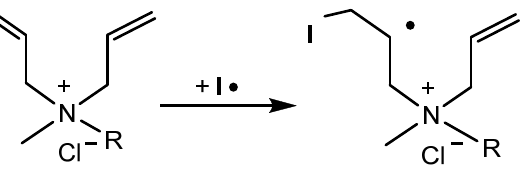
Figure 6. Primary radicals of monomers generated by radical reaction of methyl alkyl diallyl ammo- nium chloride monomers with APS initiator.